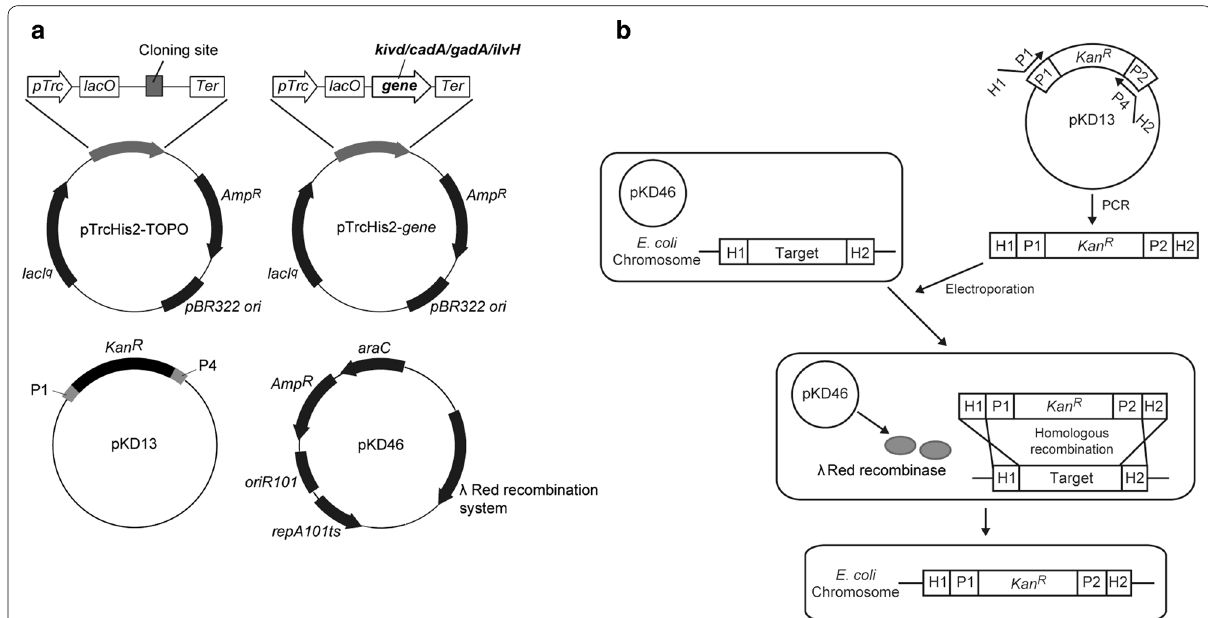
Fig. 1 Plasmids for overexpression of decarboxylase and the method for gene deletion in Escherichia coli . a Upper side plasmids for kivd overexpres- sion. Control vector ( upper left ) and pTrc-His2- kivd ( upper right ). cadA , gadA , or ilvH gene is used instead of kivd gene in the right plasmid for the over- expression of these genes. Lower side plasmids required for gene deletion in E. coli . pKD13 ( lower left ) is a template plasmid for the amplification of kanamycin resistance gene. pKD46 ( lower right ) is a plasmid that increases homologous recombination efficiency in E. coli chromosome. b A simple gene knockout strategy by homologous recombination. P1 or P2 priming site, H1 or H2 homologous recombination